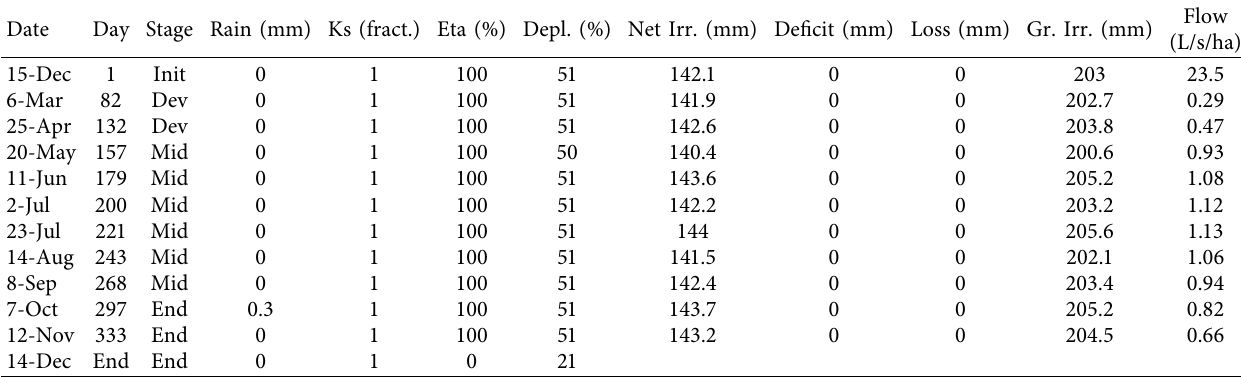
Table 14: Citrus irrigation